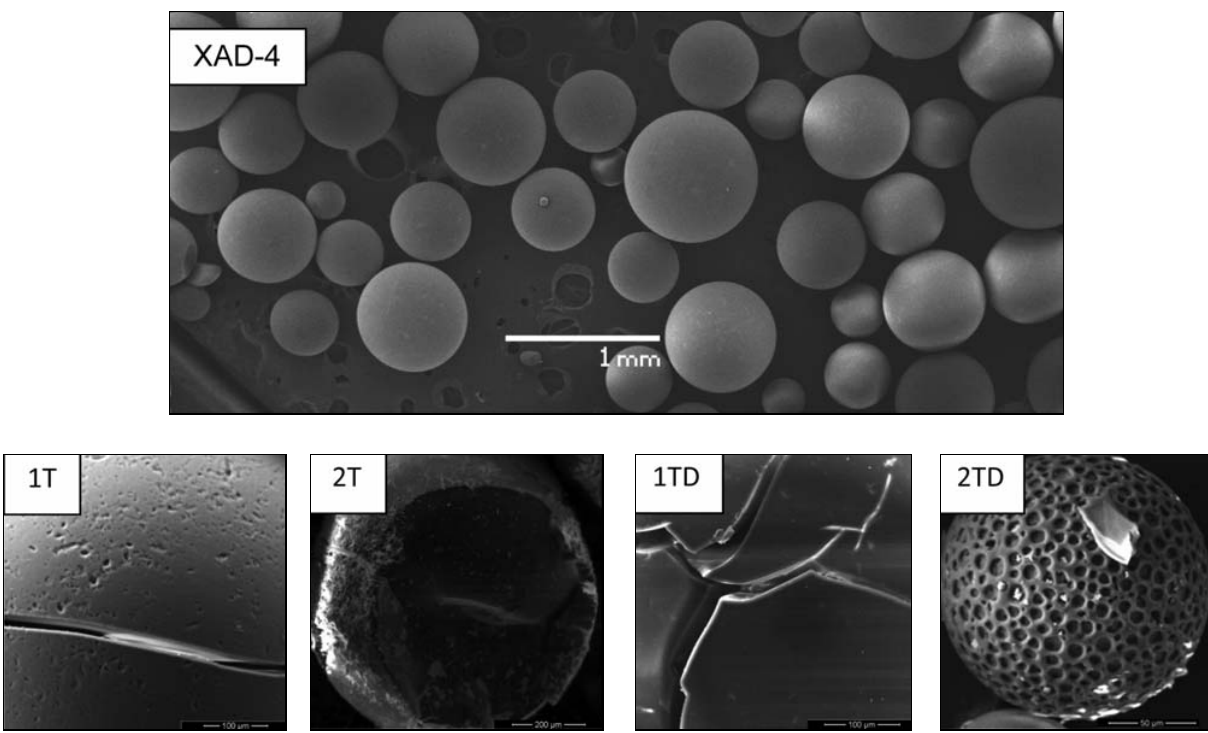
Figure 3. Captured SEM micrographs of the Amberlite XAD-4 adsorbent, and the resins 1T, 2T, 1TD, 2TD.